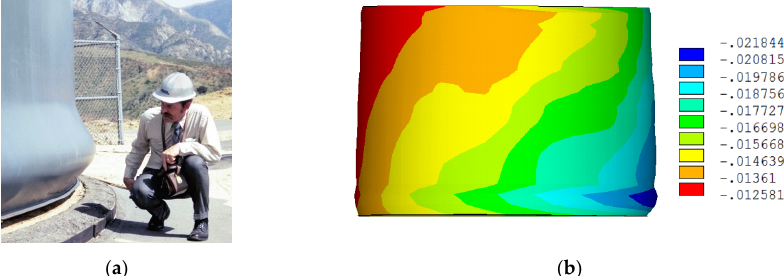
Figure 7. “Elephant-foot” buckling of the tank: ( a ) “Elephant-foot” buckling of a real tank [19]; ( b ) “Elephant-foot“ buckling deformation of the tank in this study (under El Centro ground motion, t = 2.74 s, X + Y + Z excitation).